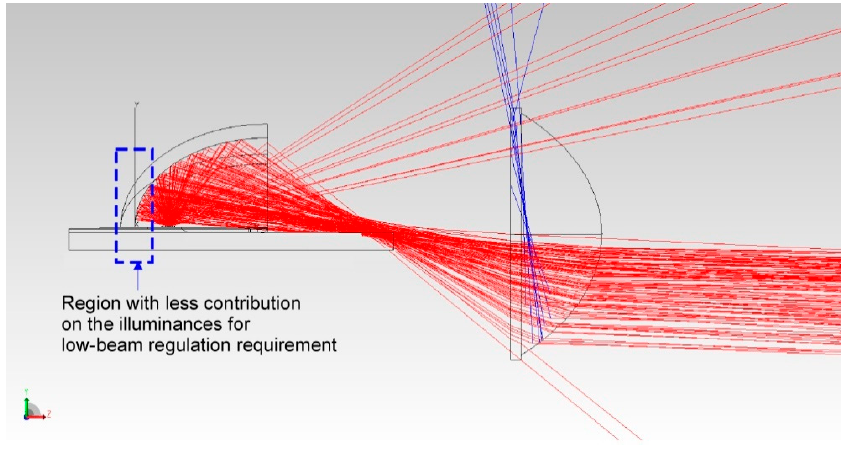
Figure 8. The structure of the projector-type LED headlamp in this study. Some of the light reflected from the back part of primary ellipsoidal reflector contributes less to the illuminances for low-beam regulation requirement.